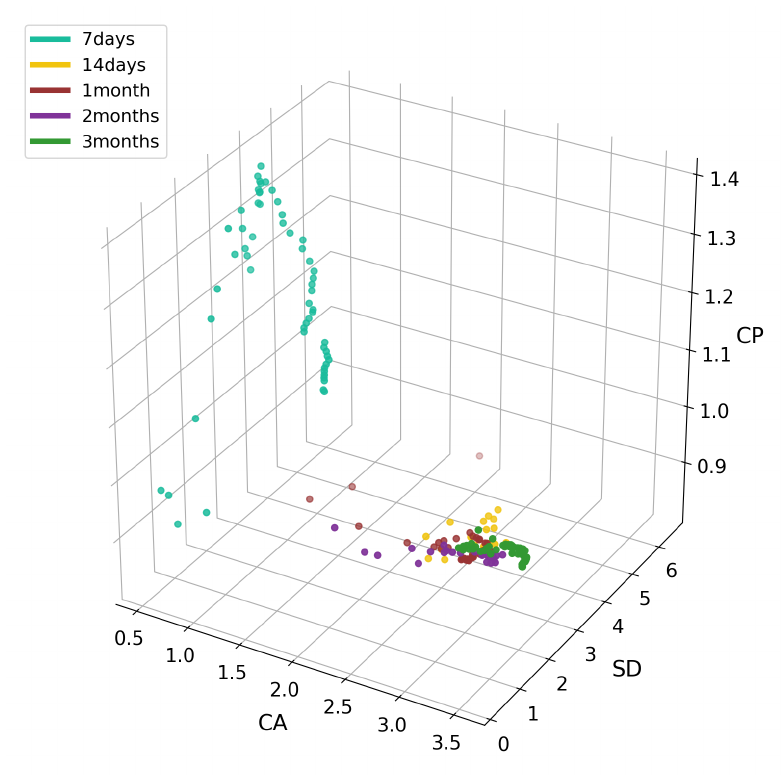
Figure 7. Dependence of objects in classes from CA, SD and CP variables.